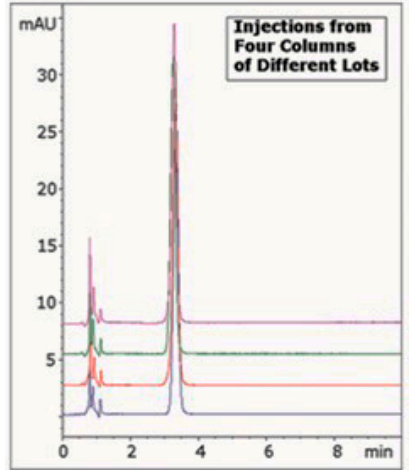
Figure 1. Overlay of chromatograms for the same analyte (diphenhydramine) taken on the same bonded phase (silica-C) of silica hydride columns made from four different synthetic batches. Mobile phase 50:50 acetonitrile/DI water + 5 mM ammonium acetate. (http://kb.mtc-usa.com/article/AA- 00918).